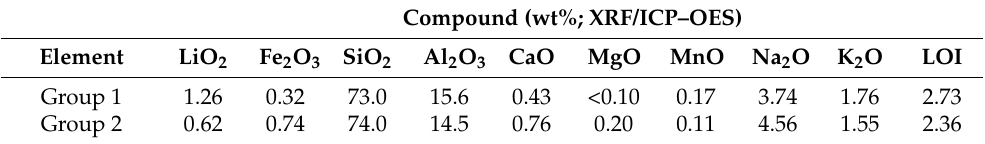
Table 4. Bulk chemical analysis of G1 and G2.